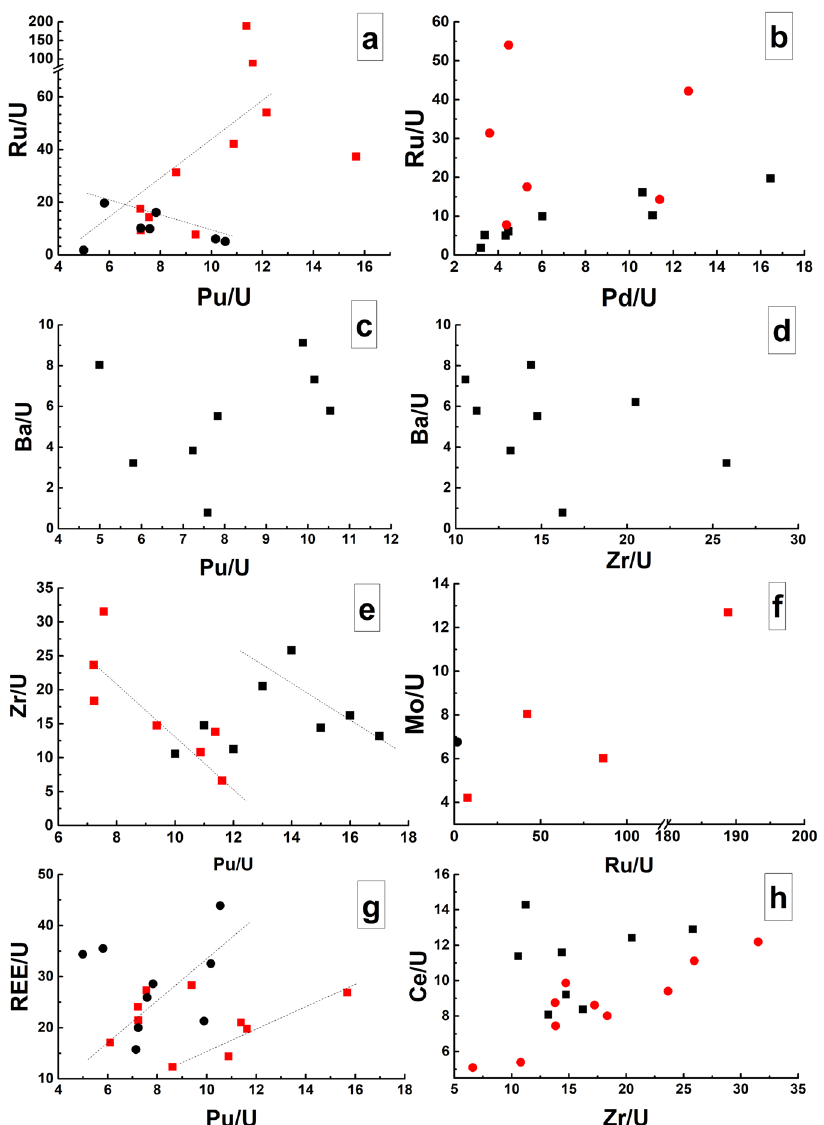
Fig. 8 Interelement correlations for fuel debris particles. Concentrations of all elements ( fi ssion products) are normalized to U content to compensate semi-quantitative character of the measurements (see text for detail). A , B Platinum group elements (Pd, Ru) plotted vs. Pu each other, respectively. C , D Barium as a function of Pu and Zr contents. E Zr vs. Pu. F Mo vs. Ru. G , H Rare Earth elements (REE) plotted vs. Pu and Zr, respectively. Black symbols — as received graphite, red — leached sample. The lines are drawn to guide an eye to possible